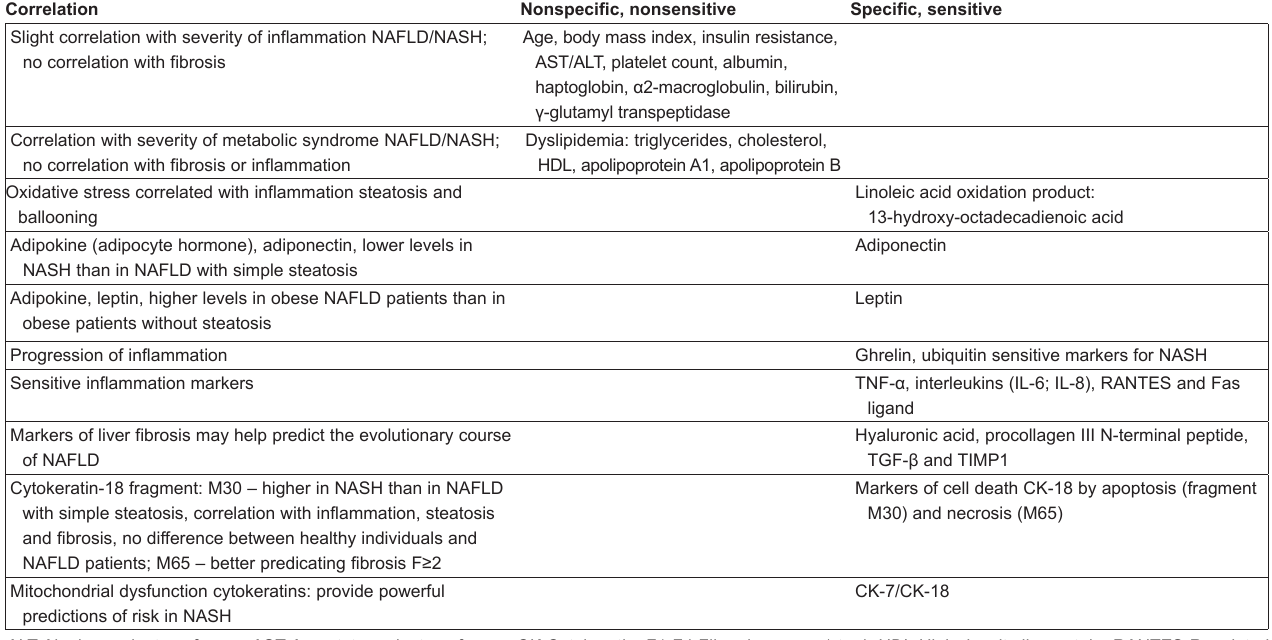
TAbLe 3 Noninvasive markers to differentiate disease progression correlated with the gold